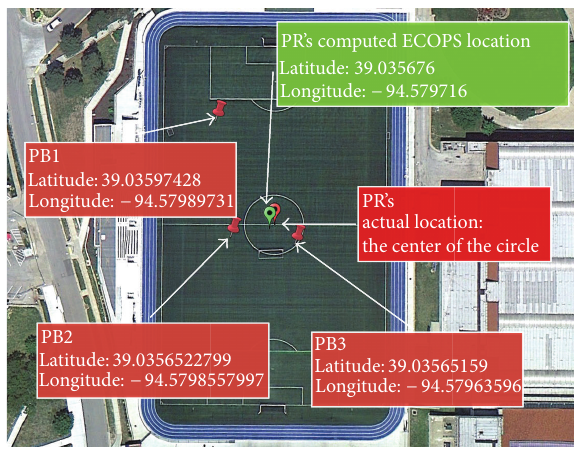
Figure 16: Distribution in error range for location estimated by PR.